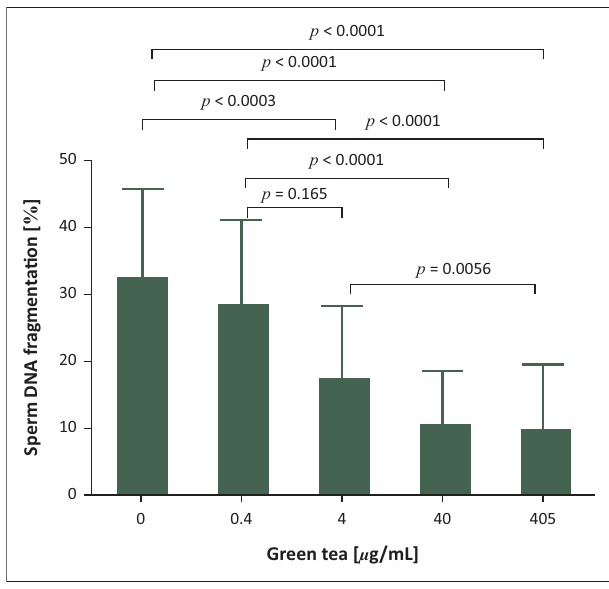
FIGURE 5: Effect of green tea aqueous extract on deoxyribonucleic acid fragmentation of human spermatozoa. Data are represented as mean ± standard deviation from normozoospermic semen samples ( n =